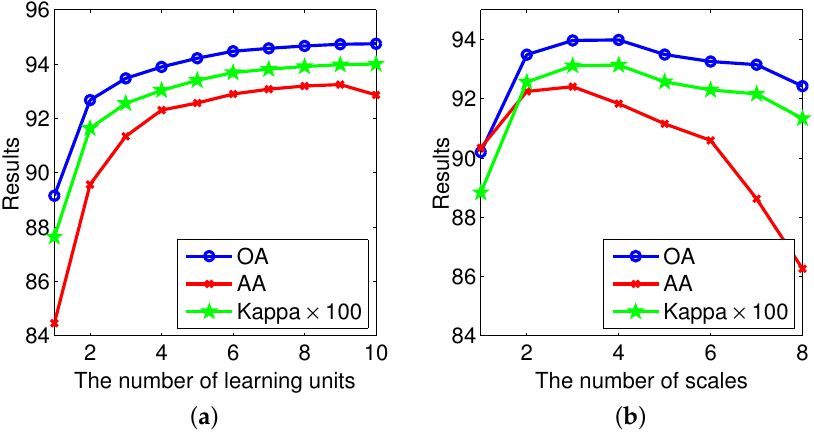
Figure 7. Effect of using different numbers of ( a ) learning units and ( b )